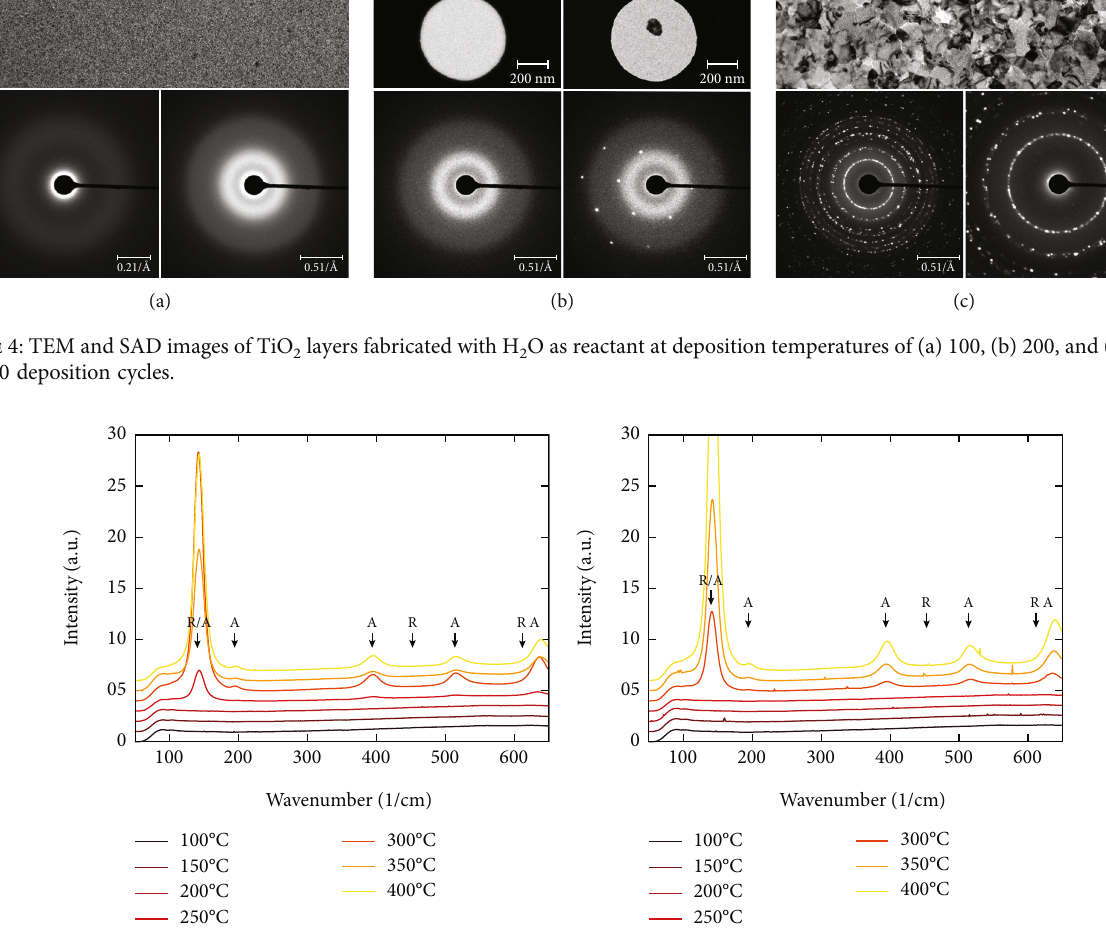
layers for (a) H O and (b) O as reactant and 2000 deposition cycles. Layers are analyzed for 2 2 3